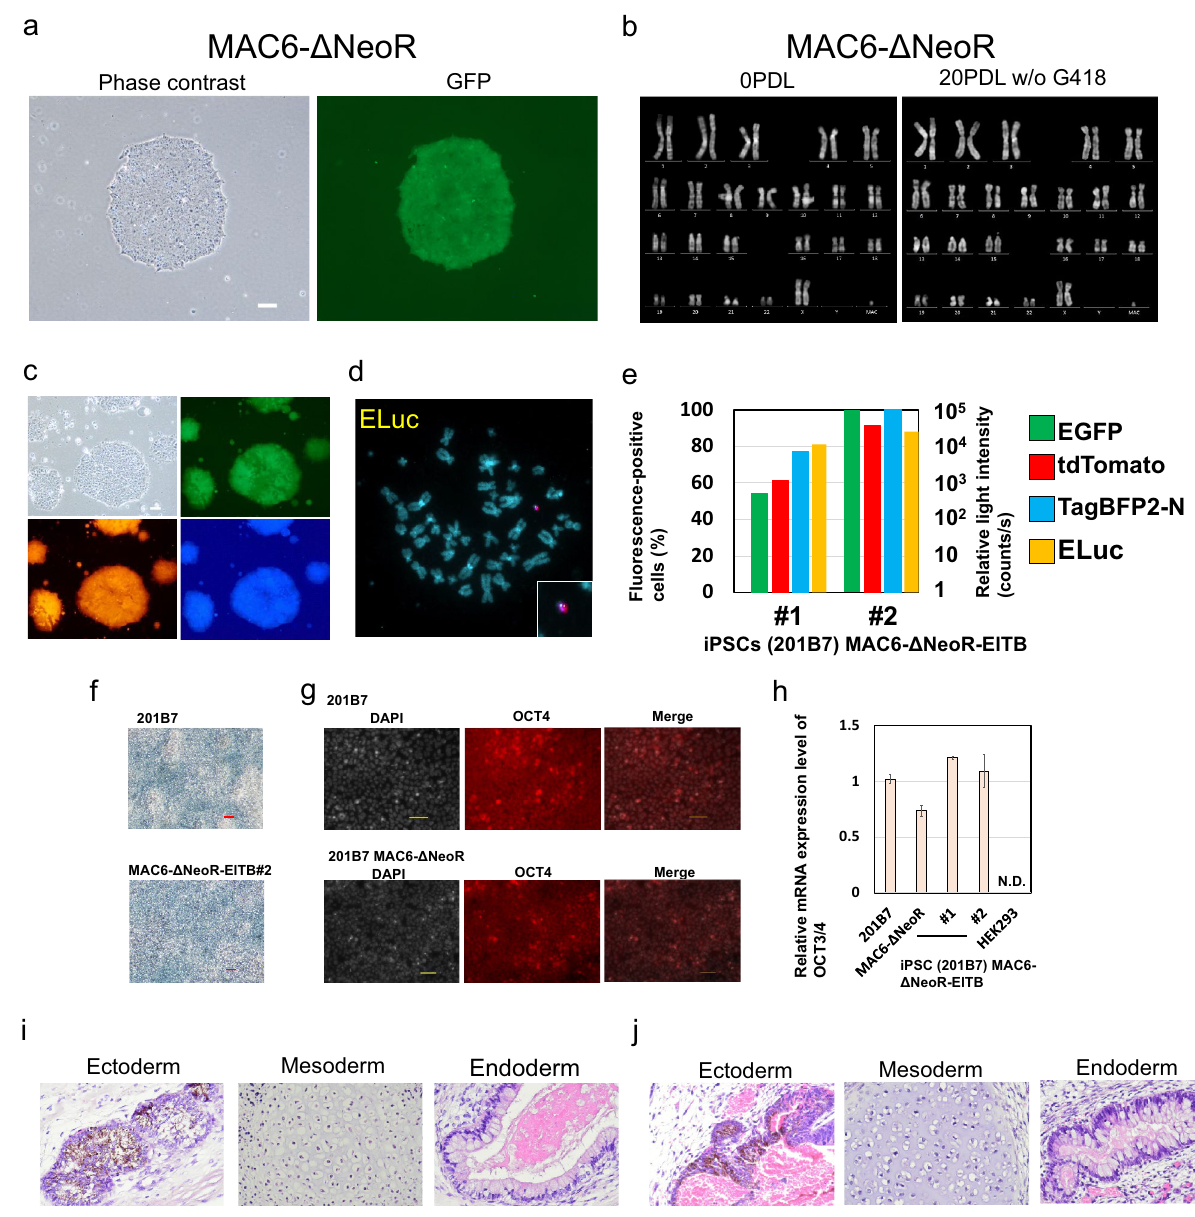
Figure 5. Characterisation of hiPSCs (201B7) that contained MAC6-ΔNeoR and 201B7/MAC6-ΔNeoR inserted with the three vectors by the SIM system. ( a ) Representative images of fluorescent protein expression in 201B7/MAC6-ΔNeoR cells. The left panel shows phase contrast and the right panel shows EGFP expression. Bar = 200 µm. ( b ) Karyotypes of hiPSCs (201B7)/MAC6-ΔNeoR during establishment (left, PDL 0) and in long- term cell culture (right, PDL 20). ( c ) Representative images of fluorescent protein expression in 201B7/MAC6- ΔNeoR cells inserted with tdTomato, BFP, and ELuc via the SIM system. Bar = 200 µm. ( d ) Representative image of FISH analysis of 201B7/MAC6-ΔNeoR cells with the three plasmids. Red: mouse cot-1 staining MAC4; green: pBG2-V0b-ins-ELuc-ins. ( e ) Two Y-axis graph showing the results of FCM analysis and luciferase assays of two clones of 201B7/MAC6-ΔNeoR cells inserted with the three plasmids. ( f ) Representative images of alkaline phosphatase staining of 201B7 and 201B7/MAC6-ΔNeoR-ElTB#2 cells. Bar = 50 µm. Alkaline phosphatase activity was detected by deposition of purple pigment. ( g ) Representative image of immunofluorescence staining for OCT3/4 in 201B7 and 201B7/MAC6-ΔNeoR cells. Bar = 50 µm. ( h ) Relative mRNA expression levels of OCT 3/4 in each cell line or clone. (n = 3). N.D. means not detected. ( i ) Teratoma formation analysis of 201B7/ MAC6-ΔNeoR cells. Left, middle, and right panels show ectodermal, mesodermal, and endodermal tissues, respectively. ( j ) Teratoma formation analysis of 201B7/MAC6-ΔNeoR-ElTB#2. Left, middle, and right panels show ectodermal, mesodermal, and endodermal tissues,